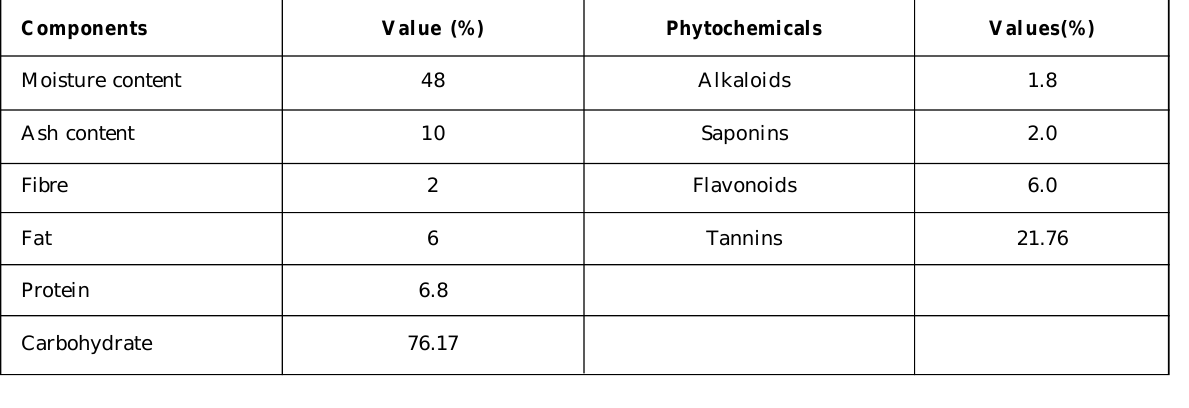
Table 1: Proximate analysis and phytochemical screening of aqueous extract of Eleusine indica